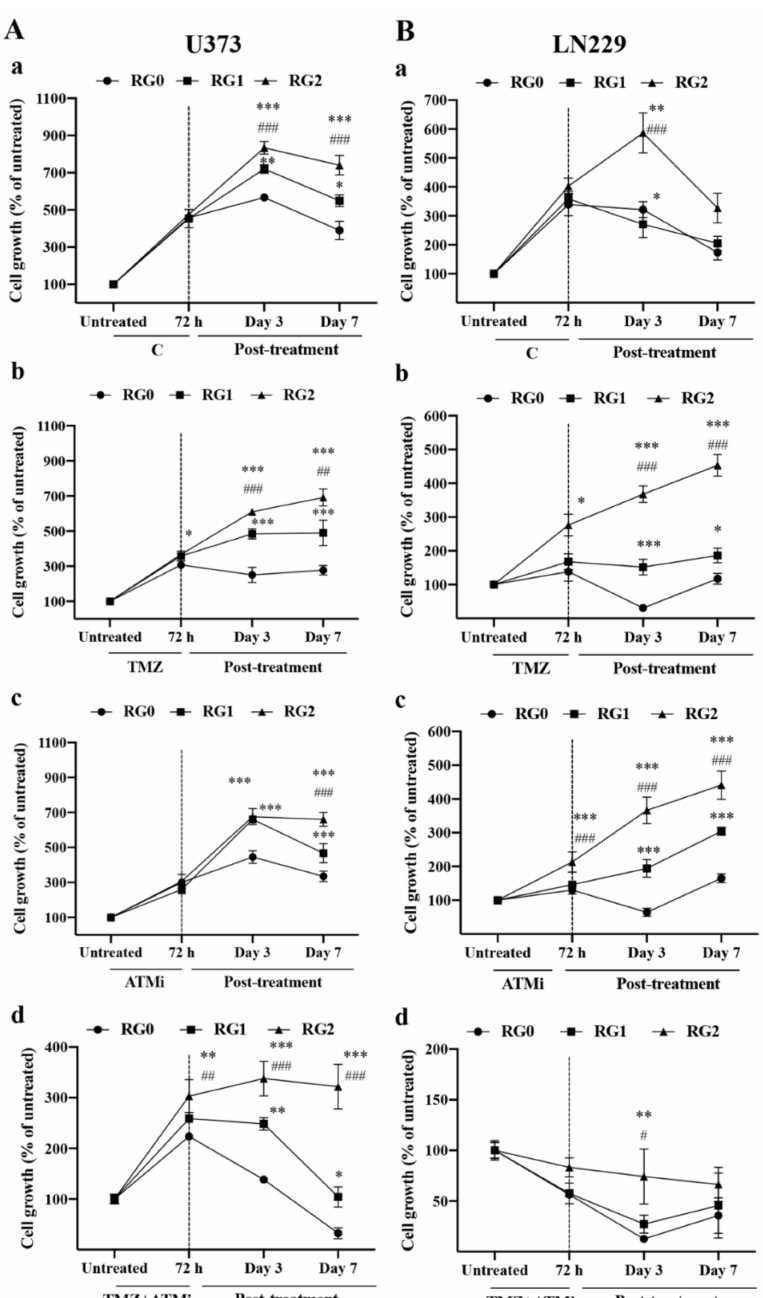
Figure 2. RG2 cells exhibit less susceptibility after TMZ treatment and higher regrowth capacity during the post-treatment period. U373 RG cells ( A ; passage 15) and LN229 RG cells ( B ; passage 12) received the treatment with 0.2% DMSO as vehicle control (C) ( A-a , B-a ), TMZ (150 µ M) ( A-b , B-b ), ATMi alone (KU-60019, 10 µ M) ( A-c , B-c ), or TMZ+ATMi ( A-d , B-d ) for 72 h, respectively. Thereafter, the media containing drugs were removed; viable cells were washed with fresh medium and cultured in normal growth medium for different periods (post-treatment). MTT assay was performed before (untreated, as seeding control), 72 h after treatment and at post-treatment time points as indicated. The results were reproduced in at least three independent experiments. RG0: regrown parental cells without TMZ treatment; RG1: regrown cells after one cycle of TMZ treatment; RG2: regrown cells after two cycles of TMZ treatment. *, p < 0.05; **, p < 0.01; ***, p < 0.001, compared with RG0; #, p < 0.05; ##, p < 0.01; ###, p < 0.001, compared with